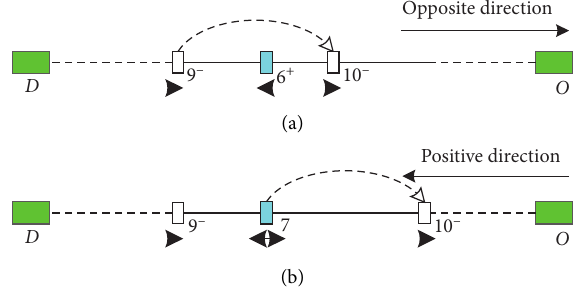
Figure 10: Bidirectional ASA determination based on an ASA of positive direction.